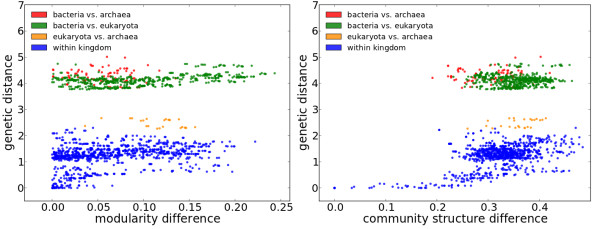
Difference in modularities (left) and community structures (right) vs. genetic distance (in substitutions per site). The gap in the middle of the plots corresponds roughly to the long branches separating bacteria from the rest (archaea are closer to eukaryota than to bacteria and bacteria are roughly as close to archaea as to eukaryota).